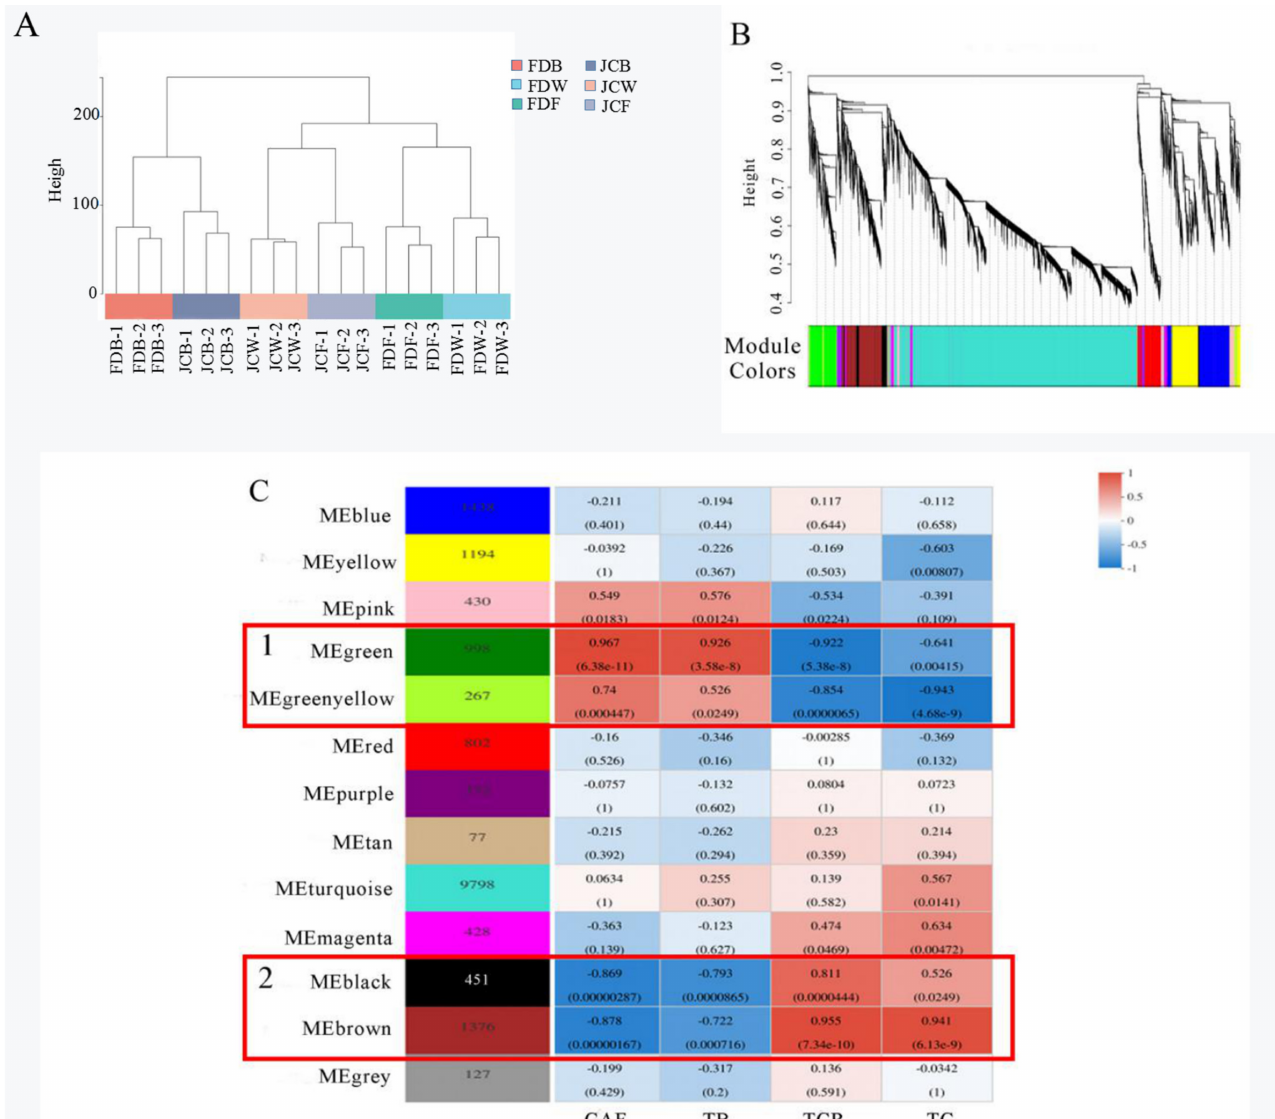
Figure 8. Co-expression network analysis. ( A ) is the sample clustering tree; ( B ) is the gene clustering tree and module cutting. Each branch of the gene clustering tree corresponds to a module. ( C ) is correlation analysis between modules and phenotypes, box 1 of two modules (green and green–yellow) were significantly positively correlated with caffeine and theobromine contents; box 2 of two modules (black and brown) were significantly positively correlated with theacrine and total amount of purine